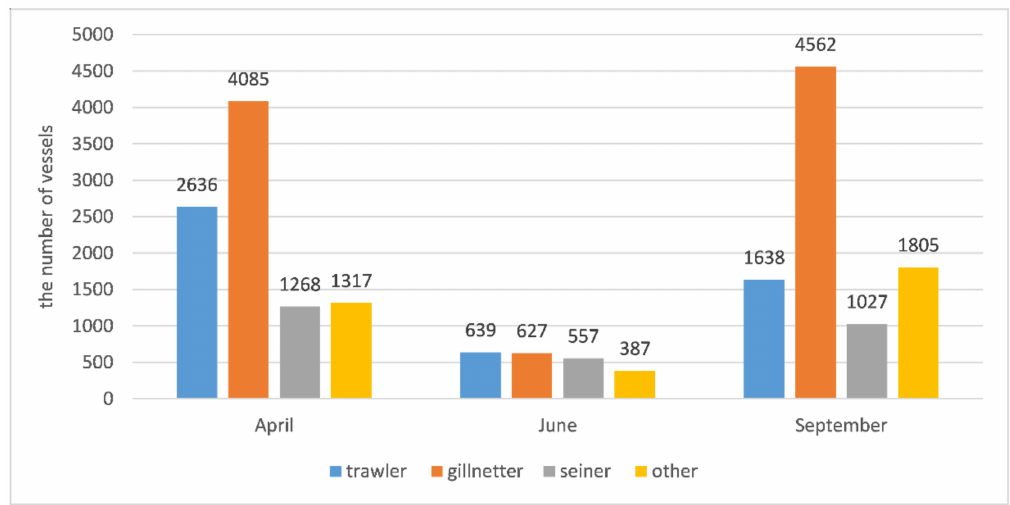
Figure 13. Number of trawlers, gillnetters and seiners for April, June and September for Chinese fishing